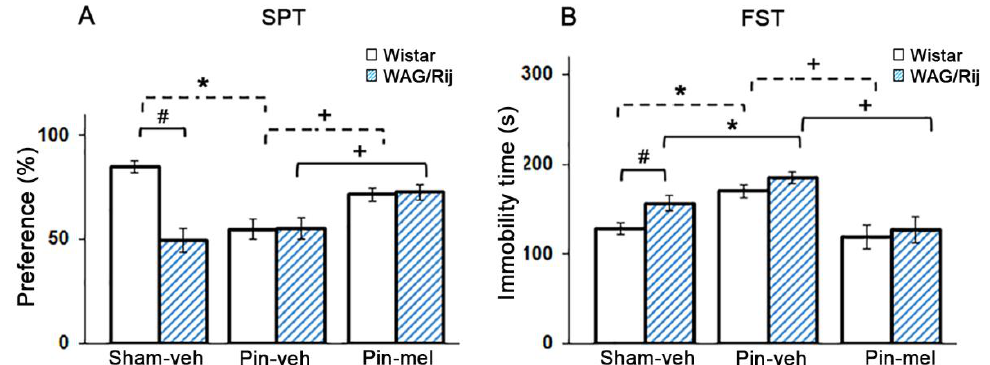
Figure 4. Depression-like behavior in Wistar and WAG/Rij rats. Effects of strain (WAG/Rij and Wistar rats), pinealectomy (Sham and Pin rats) and drug (sub-chronic 18-day-treatment with melatonin, 10 mg · kg − 1 s.c. or its vehicle) on saccharine preference in the SPT and immobility time in the FST are shown in ( A , B ), respectively. ( # ) p < 0.05 (Student’s t test) between Wistar and WAG/Rij rats; ( * ) p < 0.05 between Sham and Pin rats, treated with vehicle (two-way ANOVA (Strain and Pinealectomy) and Fisher LSD test); ( + ) p < 0.05 between vehicle-treated and melatonin-treated Pin rats (two-way ANOVA (Strain and Drug) and Fisher LSD test). Values are means ± S.E.M.